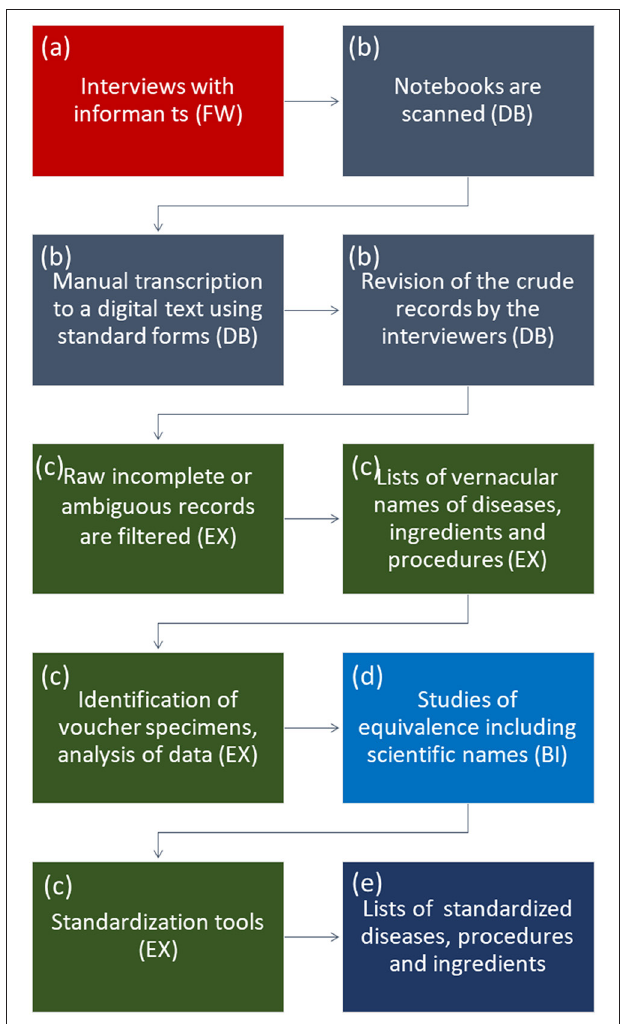
FIGURE 2 | Sequence followed for determining/interpreting ingredients and pathologies. Color codes: (a) (red) field work, (b) (gray) database, (c) (green) Excel book, (d) (light blue) bibliographical analysis, and (e) (deep blue) final report as Supplementary Table 1